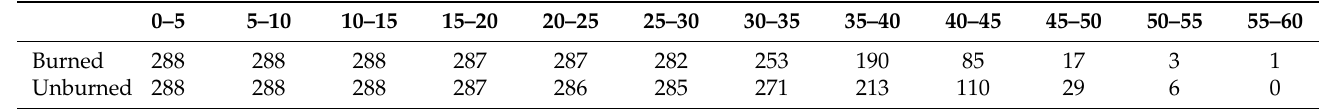
Table A2. Distribution of samples containing PAI observations by height